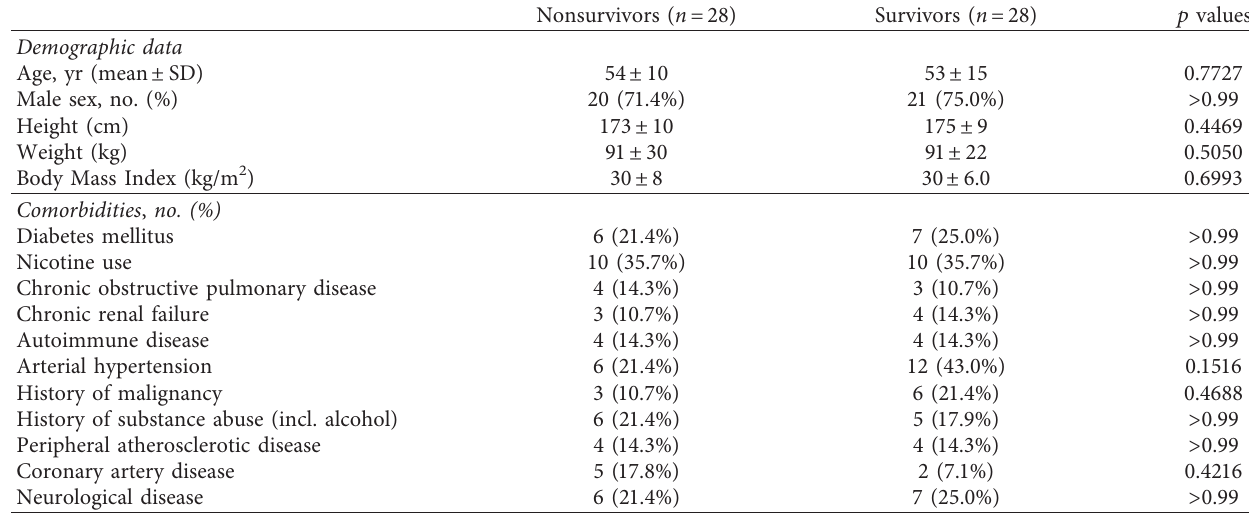
Table 1: Demographic data and comorbidities.